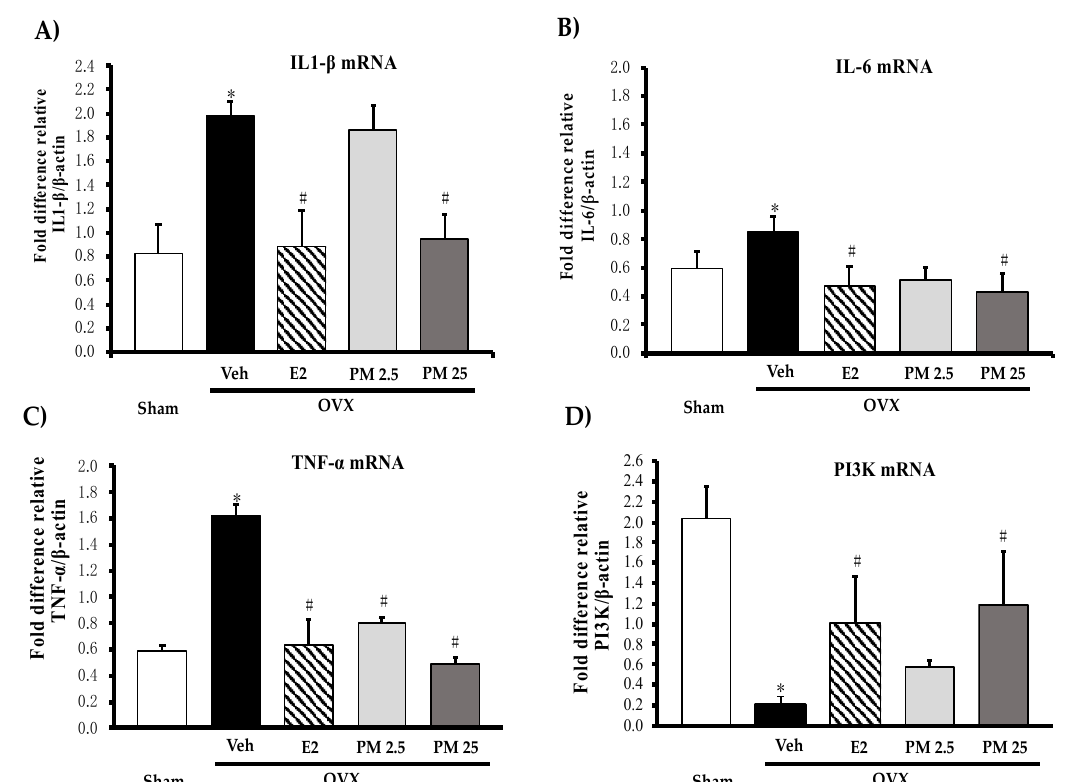
Figure 3. Effects of PM extract and 17 β -estradiol on estrogen-mediated gene on proinflammatory cytokines ( A–C ) and estrogen-mediated gene ( D ) in hippocampus. Values given were the mean ± SEM (n = 5–6). * p < 0.05 vs. sham-operated group and # p < 0.05 vs. the OVX group (post-hoc Tukey test).